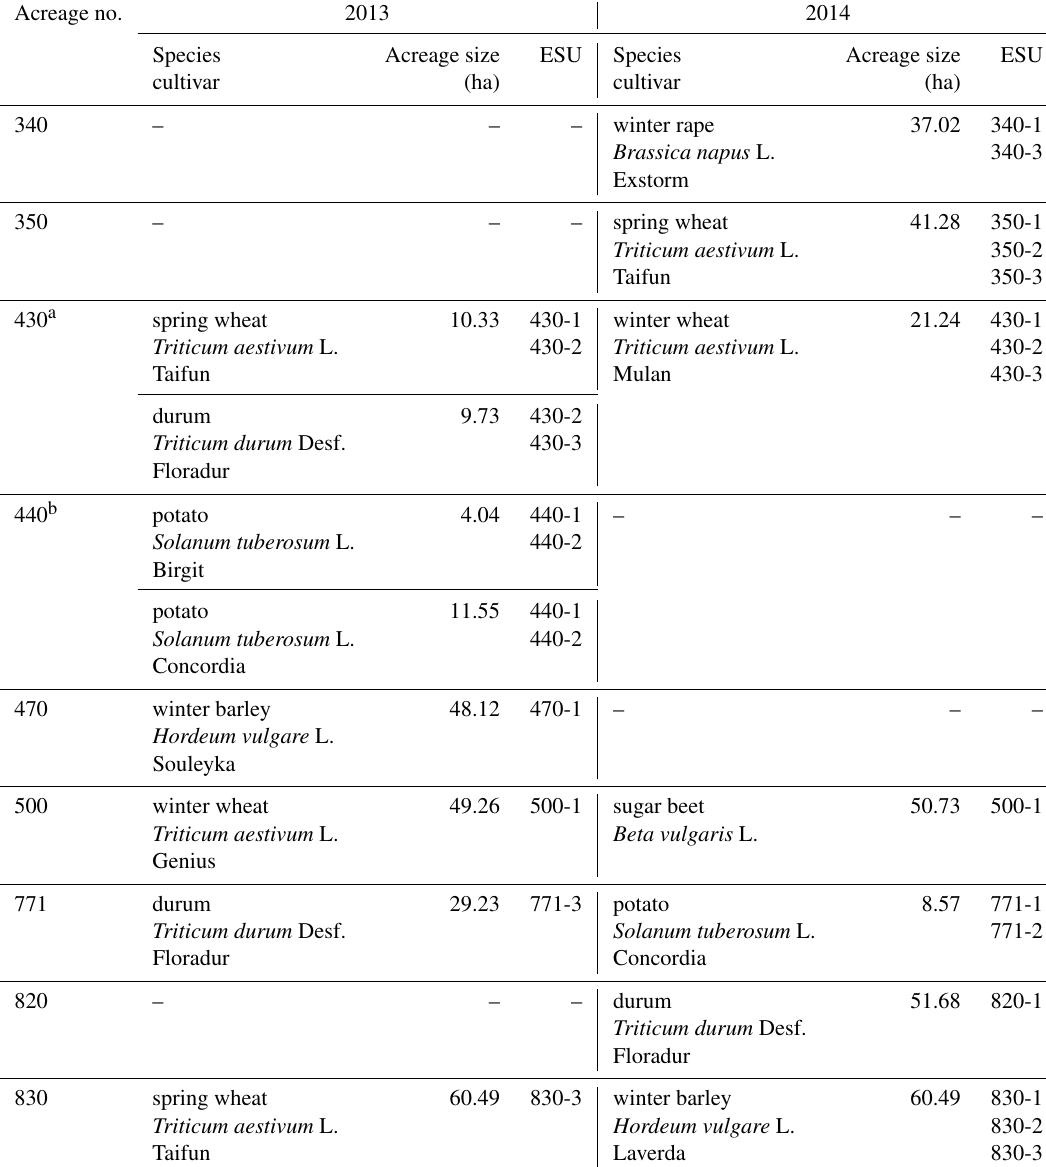
Table 1. Cultivation plan for the investigated acreages (see also Fig. 1). Acreage